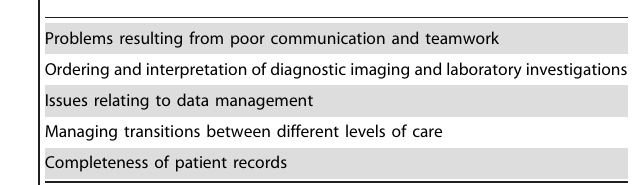
Table 2. Primary care contexts that were considered to be important by over 80% of participants after round 3.